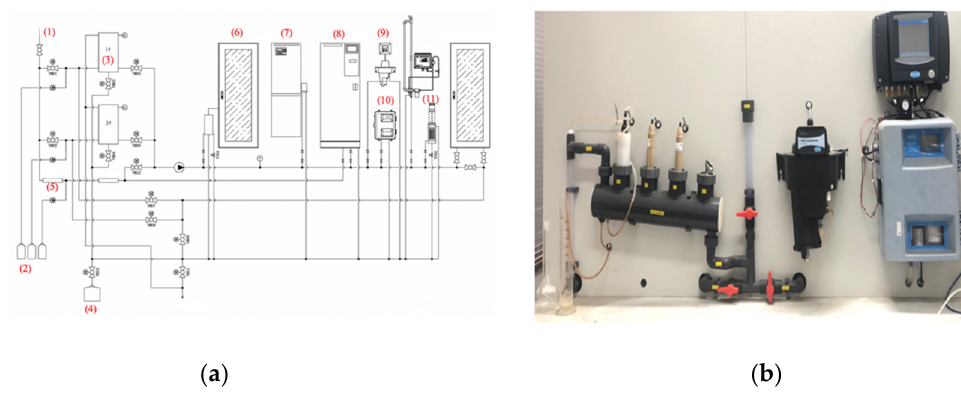
Figure 3. The simulated water pipeline system. ( a ) Structure diagram; ( b ) actual simulated pipeline system.